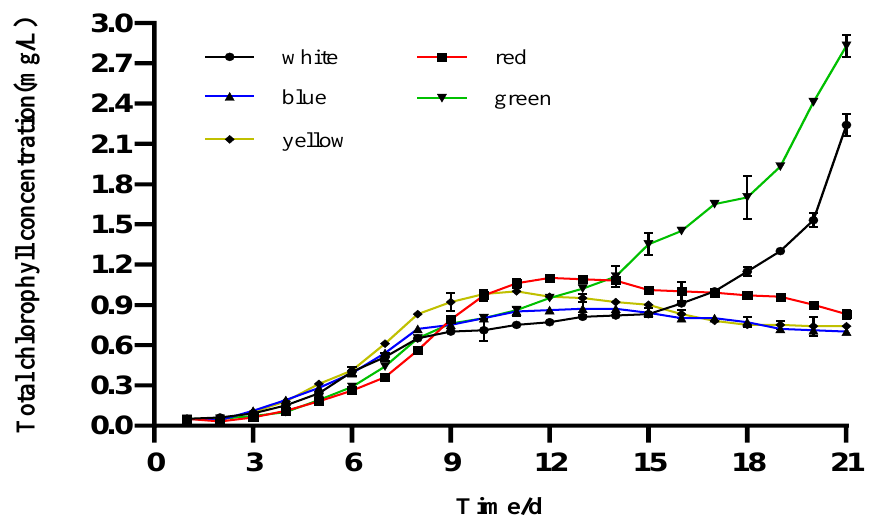
Figure 3. Daily mean values of chlorophyll- b in I. zhangjiangensis cultured under different colored LEDs (n = 3, p < 0.05 t -test).